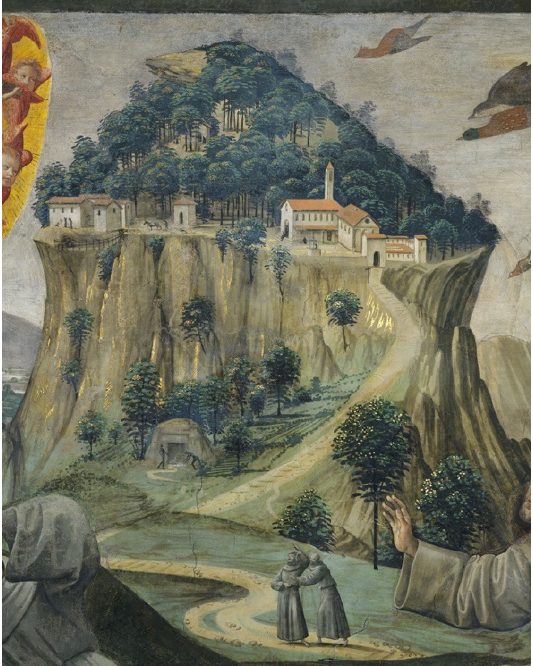
Figure 2. Domenicino Ghirlandaio, detail of La Verna from Sassetti Chapel, Santa Trinita, Florence. Fresco. 1483–1486 (photo source: Scala/Art Resource, NY).